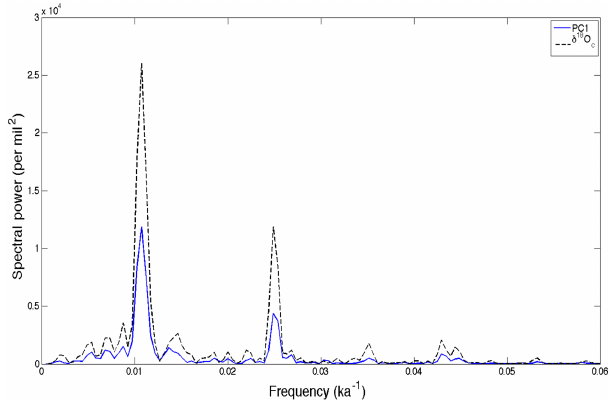
Figure 3. Spectral analysis for composite sea level stack (scaled PC1) converted to its δ 18 O sw contribution using 0.009‰m − 1 and benthic δ 18 O c stack (Lisiecki and Raymo, 2005) from 0 to